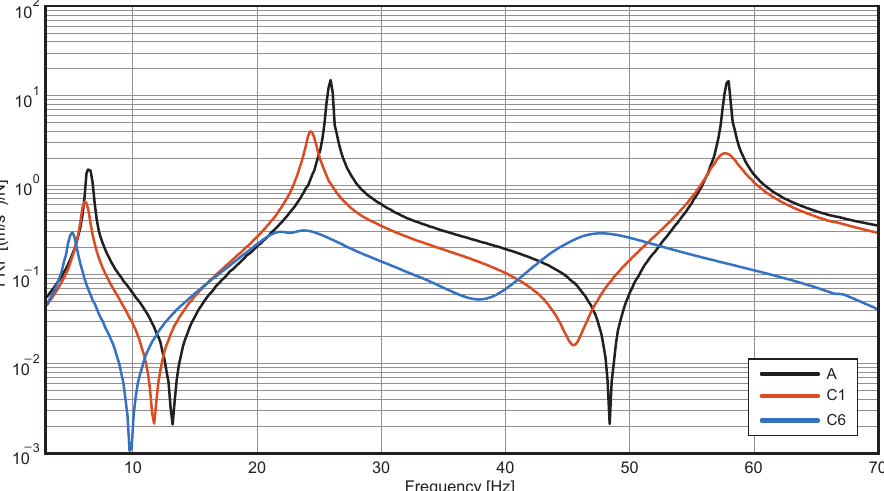
Figure 11. FRF of the reference beam (A) and the configuration with the best absolute (C6) and specific (C1) damping